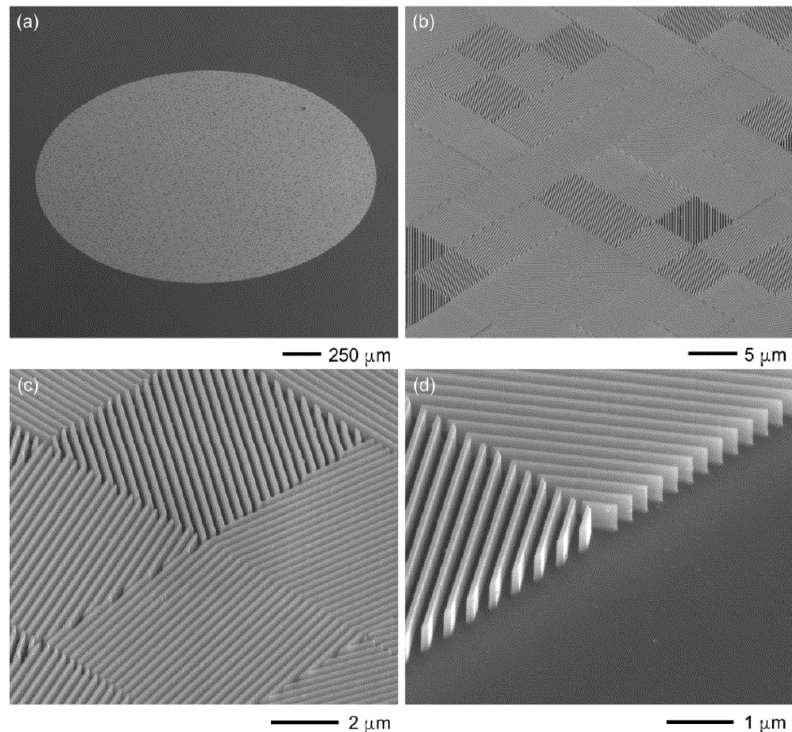
magnification. Grating period Λ = 290 nm, duty-cycle 0.5, thickness 535 nm, pixel size 6.250 µ m.